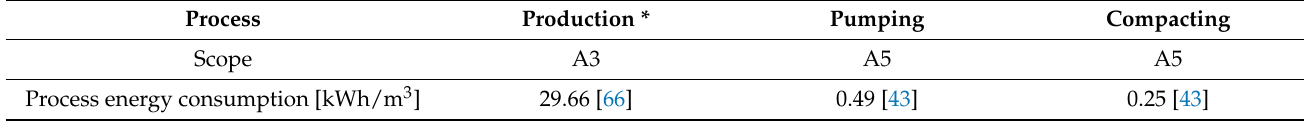
Table 5. Electricity demand for A3, A5 processes.